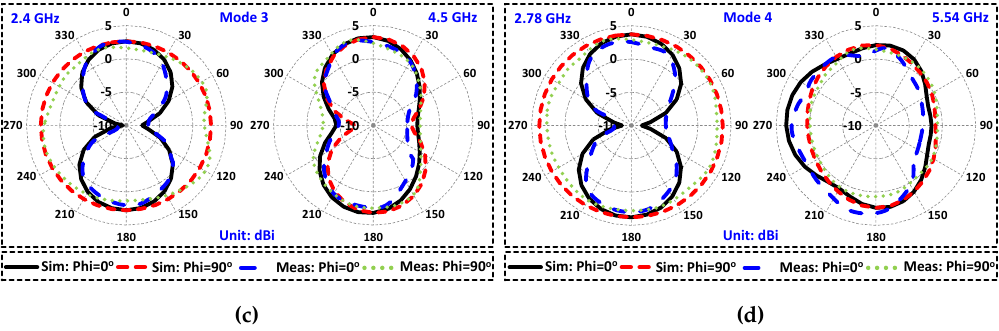
Figure 6. Simulated and measured radiation pattern at resonant frequencies (at Phi = 0 ◦ and at Phi = 90 ◦ ) of the antenna: ( a ) Mode 1; ( b ) Mode 2; ( c ) Mode 3; and ( d ) Mode 4.